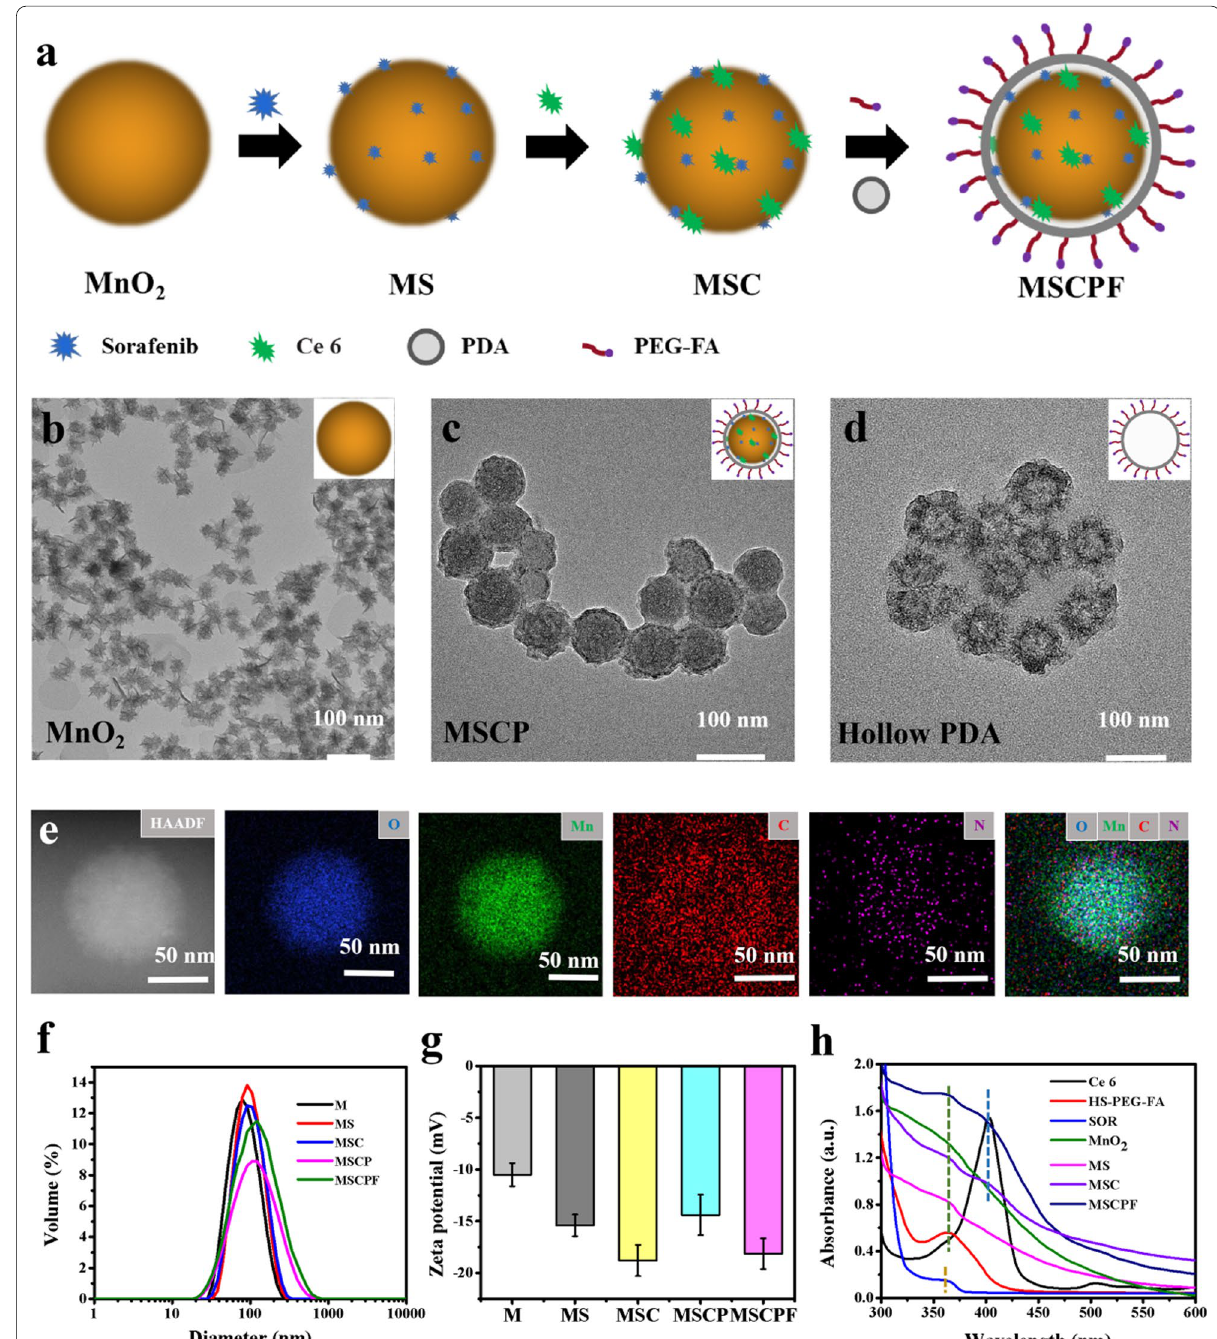
Fig. 1 Synthetic procedure and characterization of the nanoparticles. a Schematics illustrating the step-by-step synthesis of the MSCPF NPs. b–d TEM image of MnO 2 nanostructure ( b ), the obtained MSCP ( c ) and hollow PDA ( d ). e HAADF-STEM image and elemental mapping for MSCP NPs. f–g The size distribution and zeta potentials of MnO 2, MnO 2 -SOR (MS), MnO 2 -SOR-Ce6 (MSC), MnO 2 -SOR-Ce6@PDA (MSCP) and MnO 2 -SOR-Ce 6@ PDA-PEG-FA (MSCPF). h The UV–vis absorption of MnO 2 , MS, MSC, MSCP, MSCPF, SOR, Ce6, and